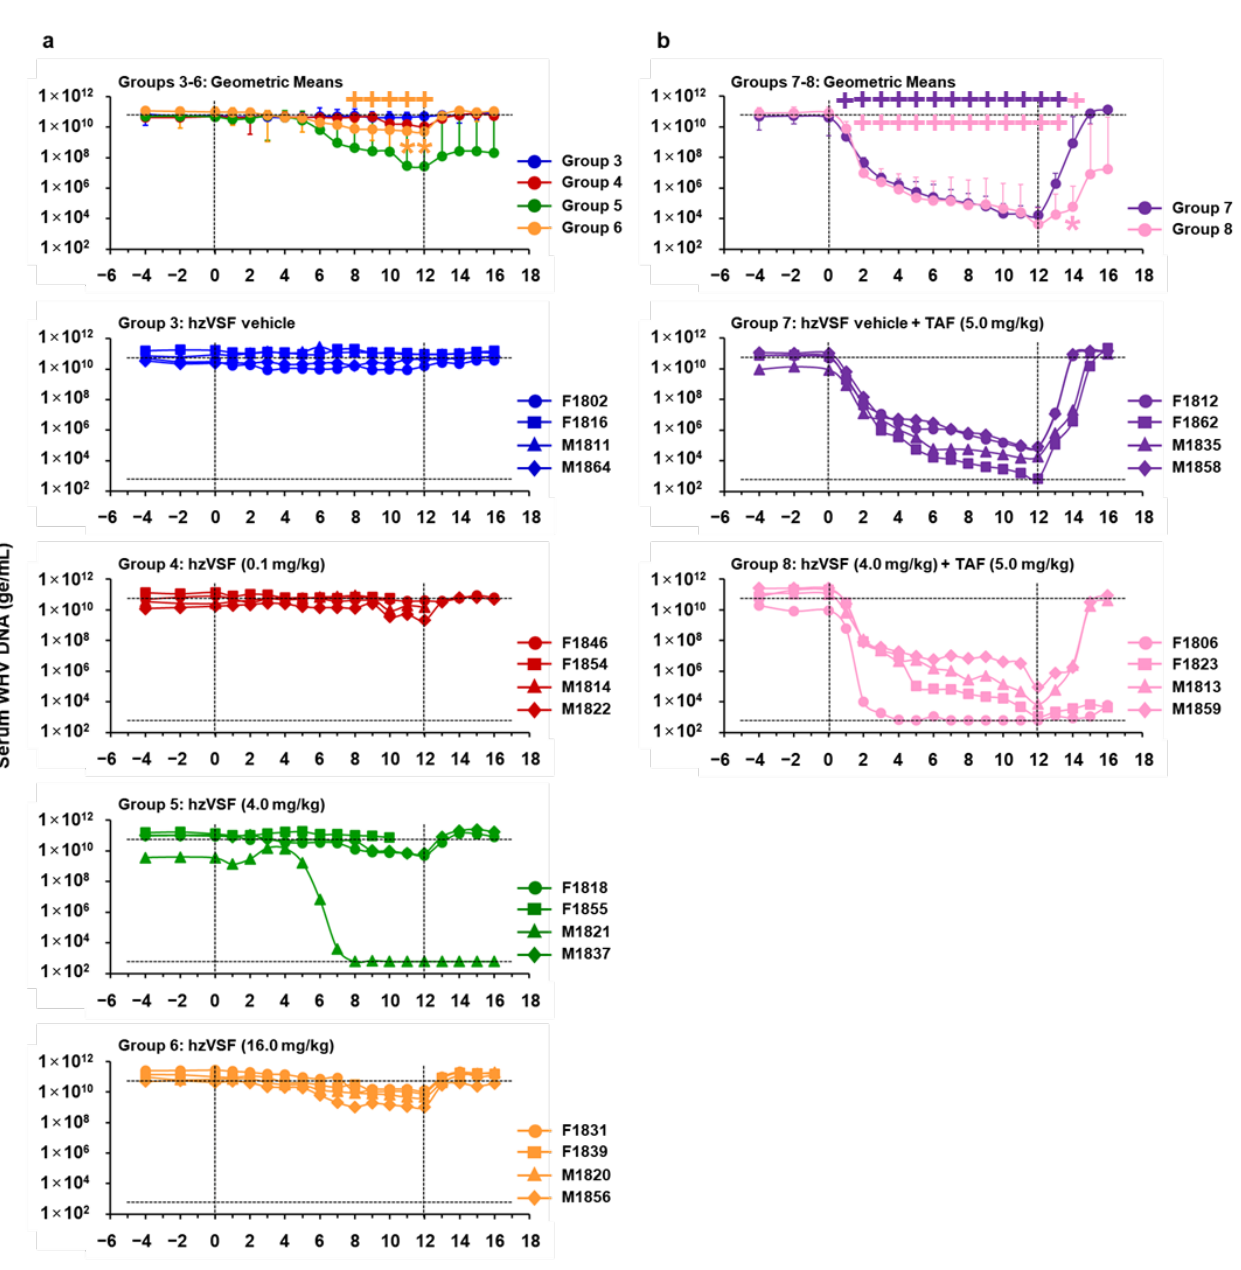
Figure 7. hzVSF monotreatment modestly reduces serum viremia, but suppression is enhanced in combination with TAF. Changes in serum WHV DNA levels relative to the pretreatment baseline (T0) of individual woodchucks treated with ( a ) placebo or hzVSF at a low, intermediate, and high dose and ( b ) TAF, alone or in combination with hzVSF at an intermediate dose. The top panels present the changes in the group geometric means of all mono and combination treatment regimens and the vertical lines indicate the standard error of the mean. The upper horizontal dotted lines present the mean viremia level of Groups 3 – 6 or Groups 7 – 8 at baseline, while the lower horizontal dotted lines indicate the detection limit for WHV DNA (i.e., 600 ge/mL). Vertical dotted lines at T0 and week 12 represent the duration of mono and combination treatment in this and the following figures. Viremia in Group 6 was significantly reduced compared to the baseline during weeks 8 – 12 (+: p < 0.05). At weeks 11 and 12, viremia in Group 6 was significantly reduced compared to Group 3 (*: p < 0.05). Compared to the baseline, viremia in Group 7 and Group 8 was significantly reduced during weeks 1 – 13 or during weeks 2 – 14, respectively (+: p < 0.05). At week 14, viremia in Group 8 was significantly reduced compared to Group 7 (*: p < 0.05). Abbreviation: ge/mL, genome equivalents or copy numbers per milliliter.